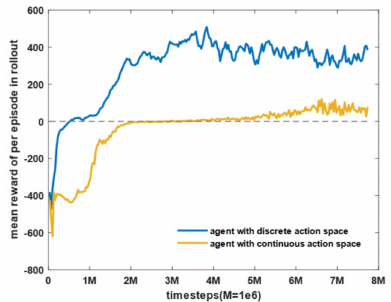
Figure 13. Training curve of the agents using different action spaces.